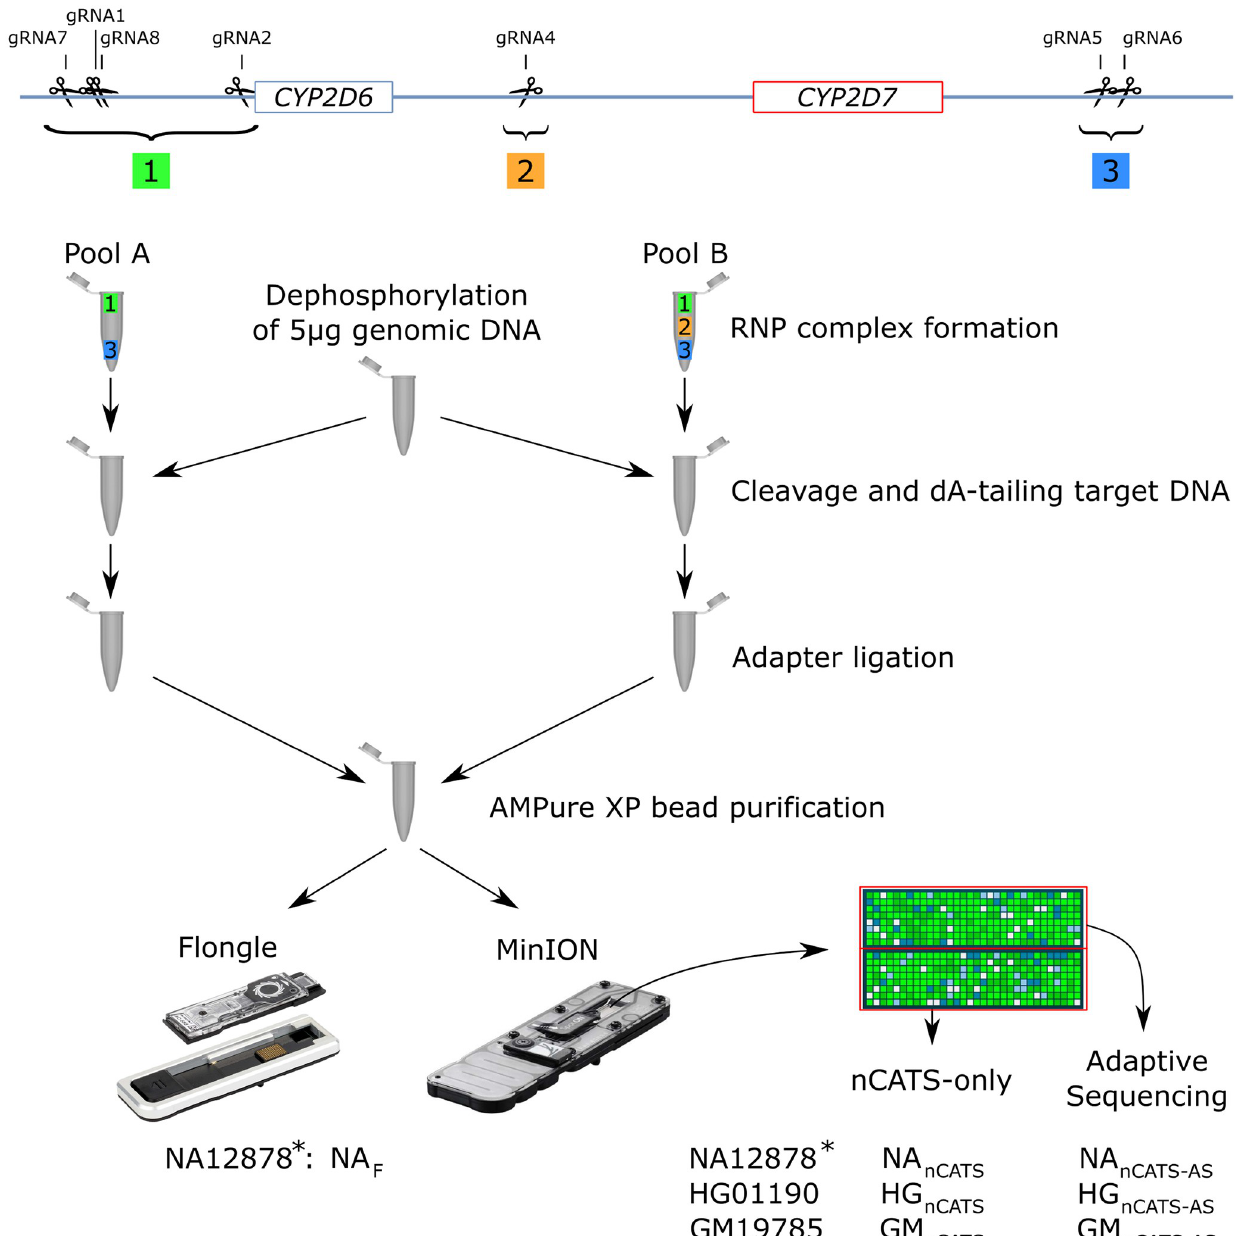
Fig 1. Enrichment and sequencing workflow adapted from the ‘Cas9 targeted sequencing’ protocol from ONT. Two different pools of gRNAs were made. Pool A only contains gRNAs that cut upstream and downstream the CYP2D6-CYP2D7 locus (gRNA7, gRNA1, gRNA8, gRNA2, gRNA5, gRNA6), Pool B also contains a gRNA that cuts between CYP2D6 and CYP2D7 (gRNA4). After dephosphorylation of the genomic DNA, half of the DNA was cleaved by the RNP with the gRNAs of Pool A, and the other half was cleaved by the RNP with the gRNAs of Pool B. After cleavage, the adaptors were ligated at the cleavage site. Next, the two pools were mixed again and purified with AMPure XP beads. The NA12878 libraries were sequenced on a Flongle (NA F ) and on a MinION flow cell. The HG01190 and GM19785 libraries were only sequenced on a MinION flow cell. On the runs using a MinION flow cell, half of the pores were controlled by the adaptive sequencing software (NA nCATS-AS , HG nCATS-AS , and GM nCATS-AS ), and the other half sequenced conventionally (NA nCATS , HG nCATS , and GM nCATS ). � : The NA12878 libraries were used for preliminary optimization purposes and were created with only one pool containing 8 (NA F ) or 9 gRNAs (NA nCATS-AS and NA nCATS